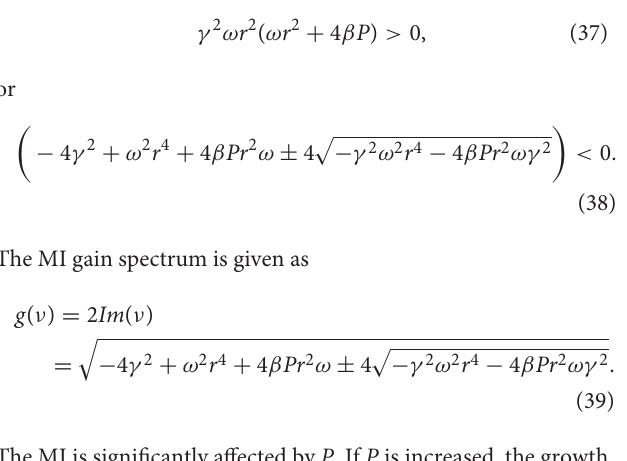
1.5 0.4cos t , δ 0 ( t ) = +